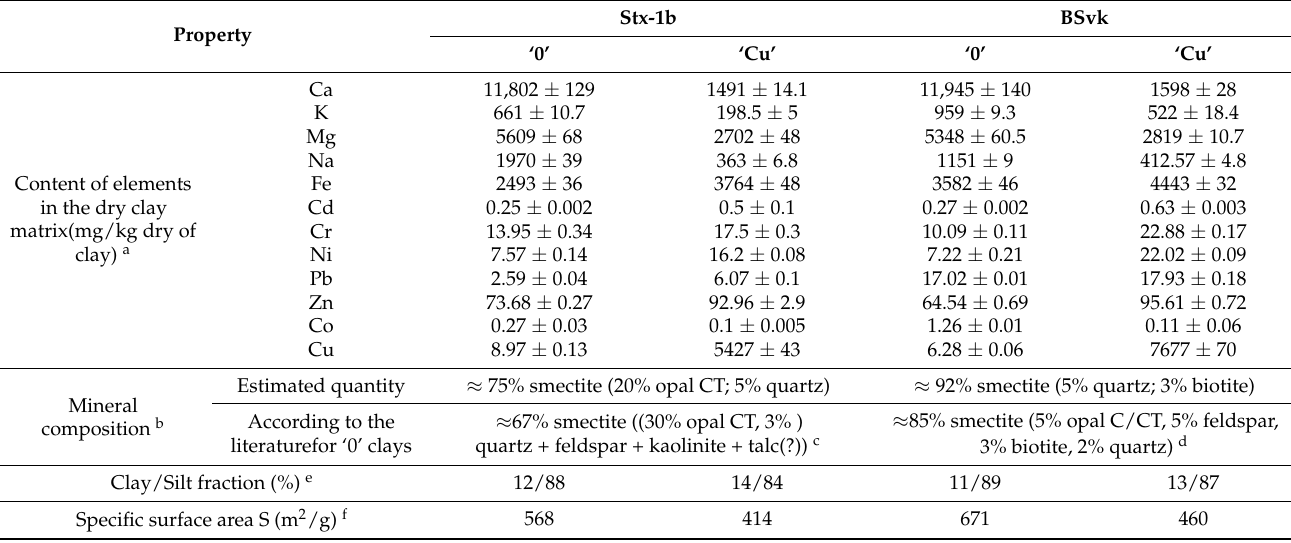
Table 2. Properties of the clays investigated in this